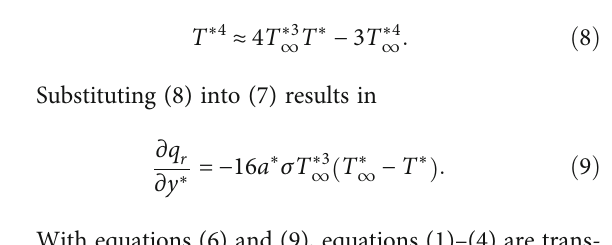
Figure 2: Di ff erent instance of time t for temperature fi eld when Ec = 0 : 1 , Pr = 6 : 2 , H = 2 , and F = 1 .